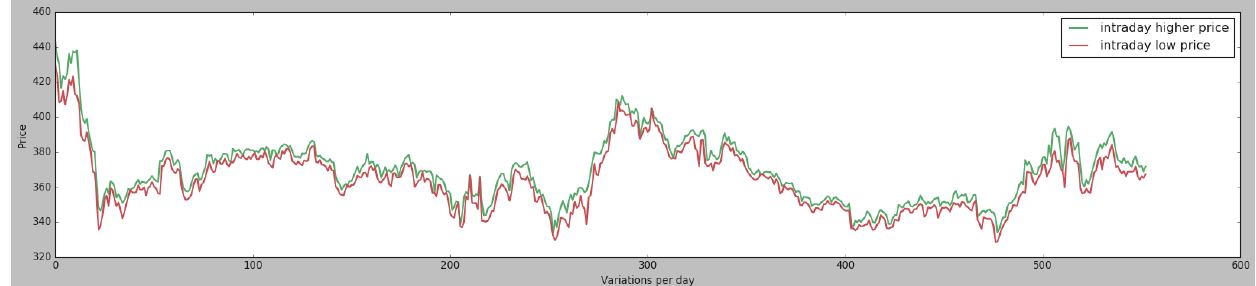
Figure 2. CZ symbol price variation.